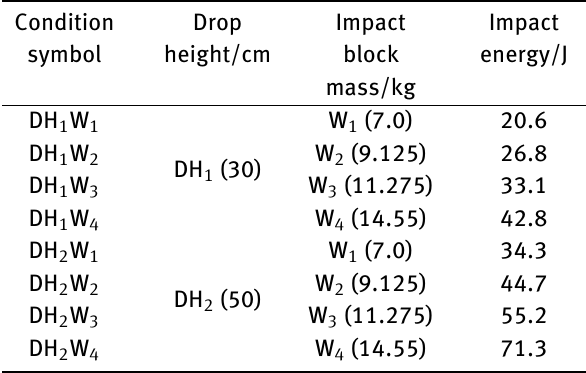
Table 2: Experimental conditions of drop